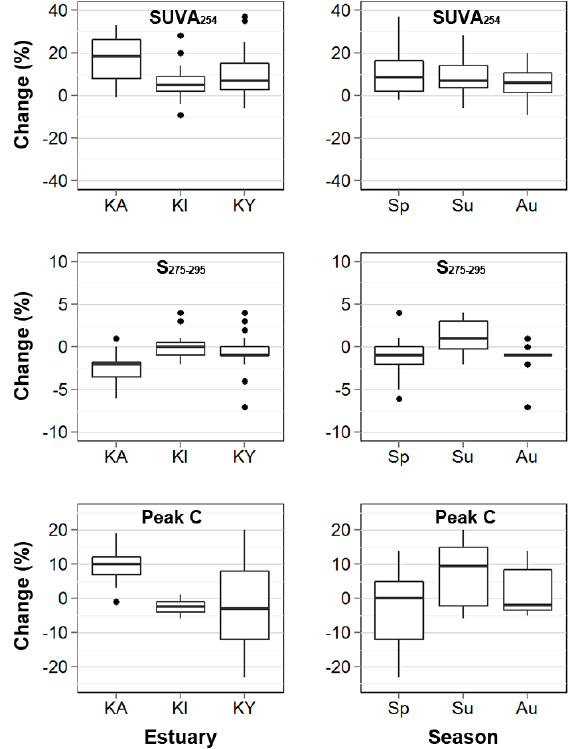
Fig. 5. Box plots showing 1 (%)-values of SUVA 254 , slope coeffi- cient S 275 − 295 and fluorescent peak C variables during the degra- dation experiment. Whiskers indicate the minimum and maximum observations, lower and upper ends of boxes indicate lower and up- per quartiles, and thick horizontal line is the mean value of the data set. Circles denote outliers in the data. Positive values indicate an in- crease of the variable during the experiment, negative value means loss. On the left side is change between estuaries and on the right side change between seasons. KA: Karjaanjoki, KI: Kiiminkijoki and KY: Kyrönjoki. Au: autumn, Sp: spring and Su: summer.